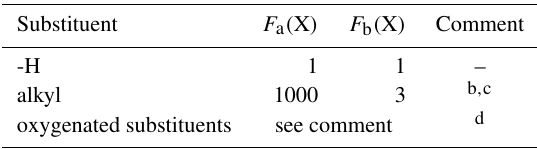
Table 9. Substituent factors, F a (X) and F b (X), for addition of O 2 to stabilized peroxide-bicyclic radicals. Parameters shown are for 298K, but are assumed to apply to the atmospheric temperature range a